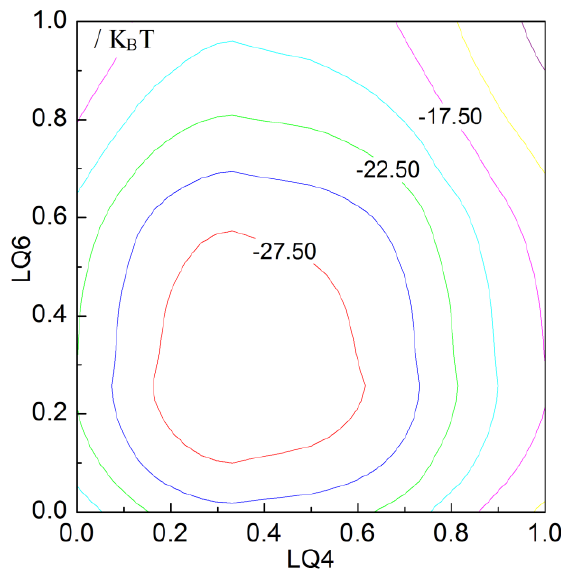
Figure 7. The free energy surface (FES) as the function of LQ4 and LQ6 in the nucleation process of NaCl crystal in the solutions (NaCl:H 2 O = 223:2000).